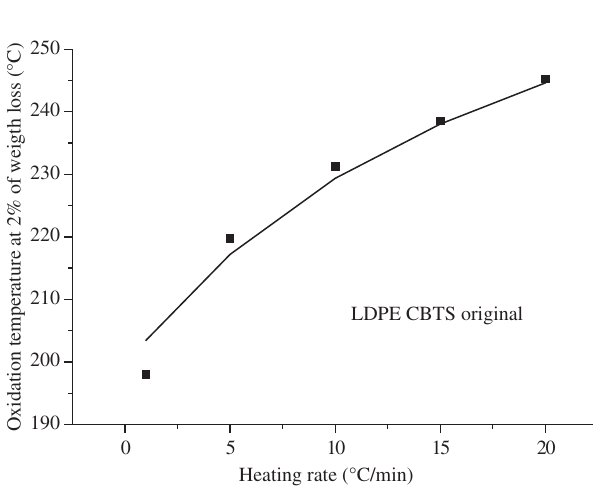
Figure 1. Typical curve of OOT as a function of heat rate.